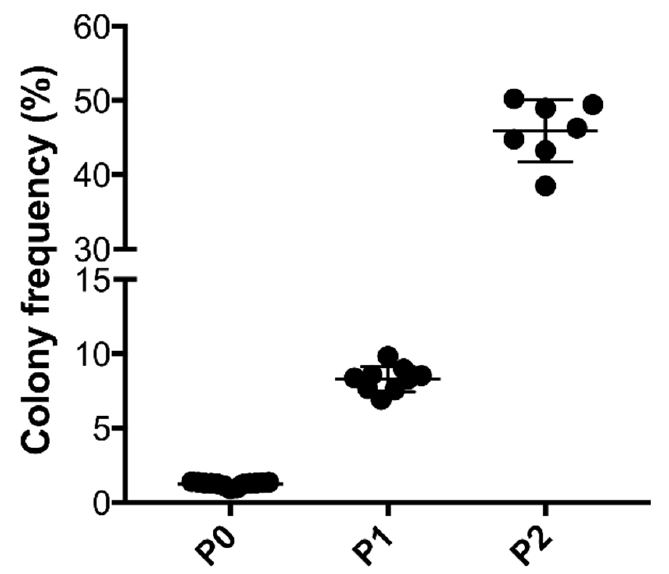
Figure 2. Colony-forming unit assay of tissue-like stromal vascular fraction (tSVF) at P0 (10,000 cells seeded), P1 (1000 cells seeded) and P2 (1000 cells seeded) to examine cell colony formation. The number of violet/blue-stained colonies is expressed as a percentage of total seeded nucleated cells. P = passage.